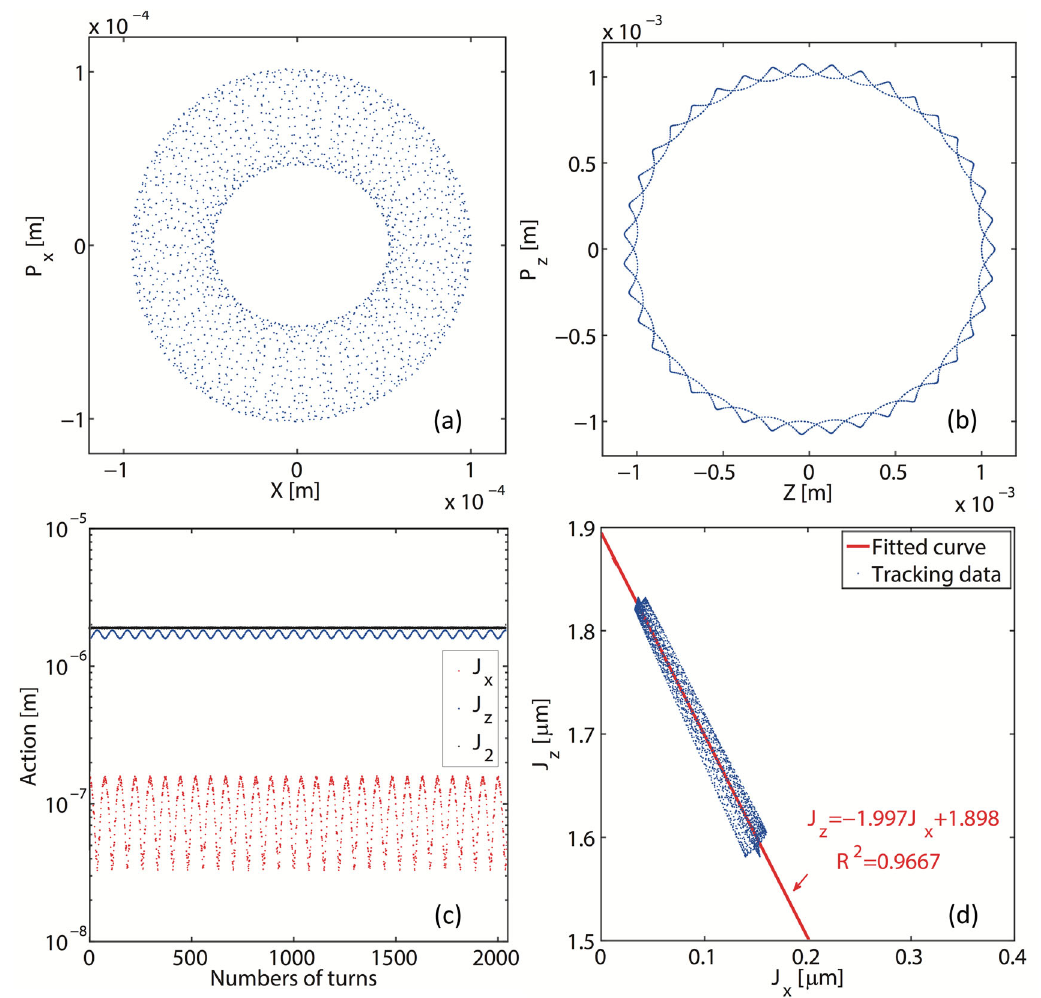
FIG. 7. The upper two plots are the horizontal and vertical normalized phase space, respectively. The lower left plot shows the actions J , J , and J 2 vs turns. The lower right plot shows the tracking data of the test particle, the corresponding linear fit equation, and the x z R-squared of the